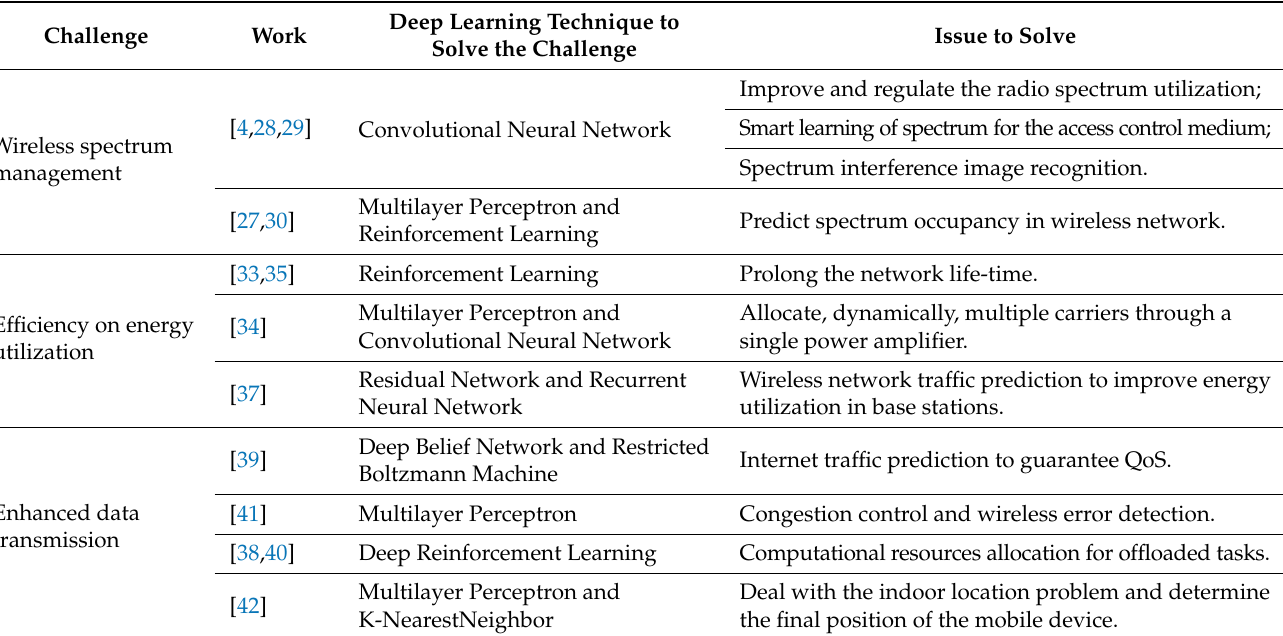
Table 3. Challenges of cognitive networks solved by deep learning